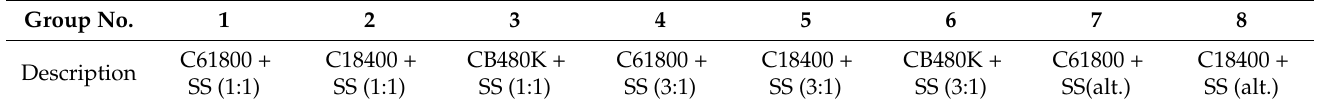
Table 2. Set of groups 1